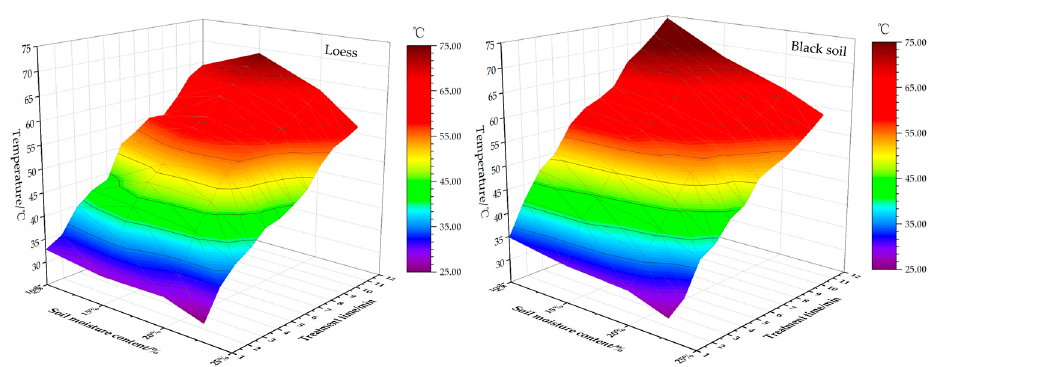
Figure 31. Variation in internal temperature in the soil irradiation area with irradiation time and soil moisture content.